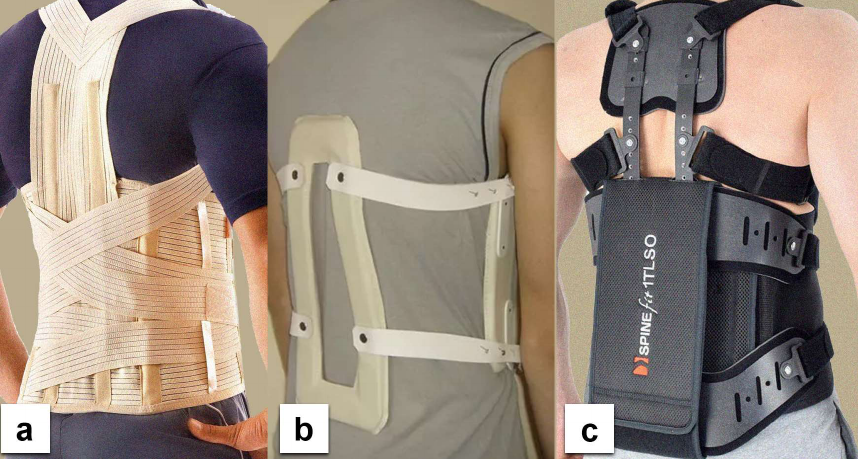
Figure 1. The orthoses used in the study ( a )—Hohmann-type lace brace, ( b )—Jewett orthosis, ( c )—TLSO.